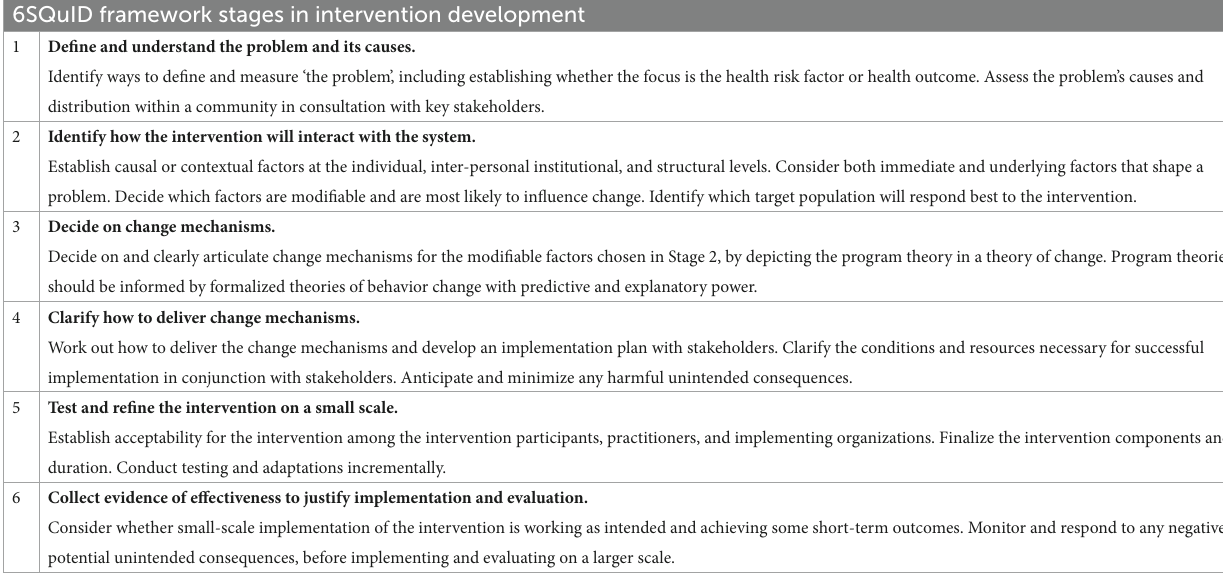
6SQuID framework stages in intervention